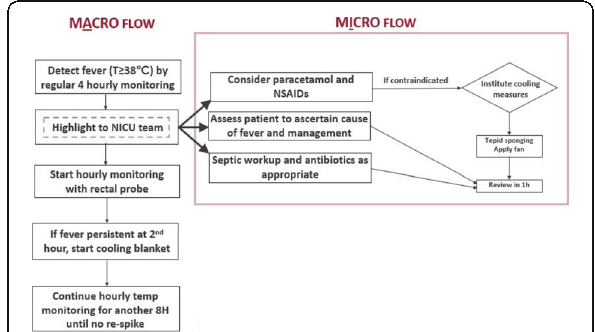
Fig. 1 (abstract 000598). See text for description